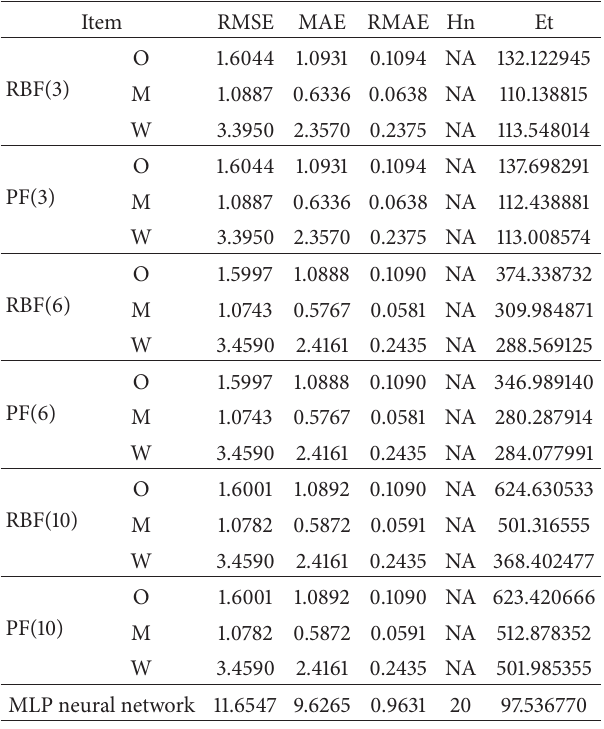
Table 4: RMSE, MAE, and RMAE refer to SVR and